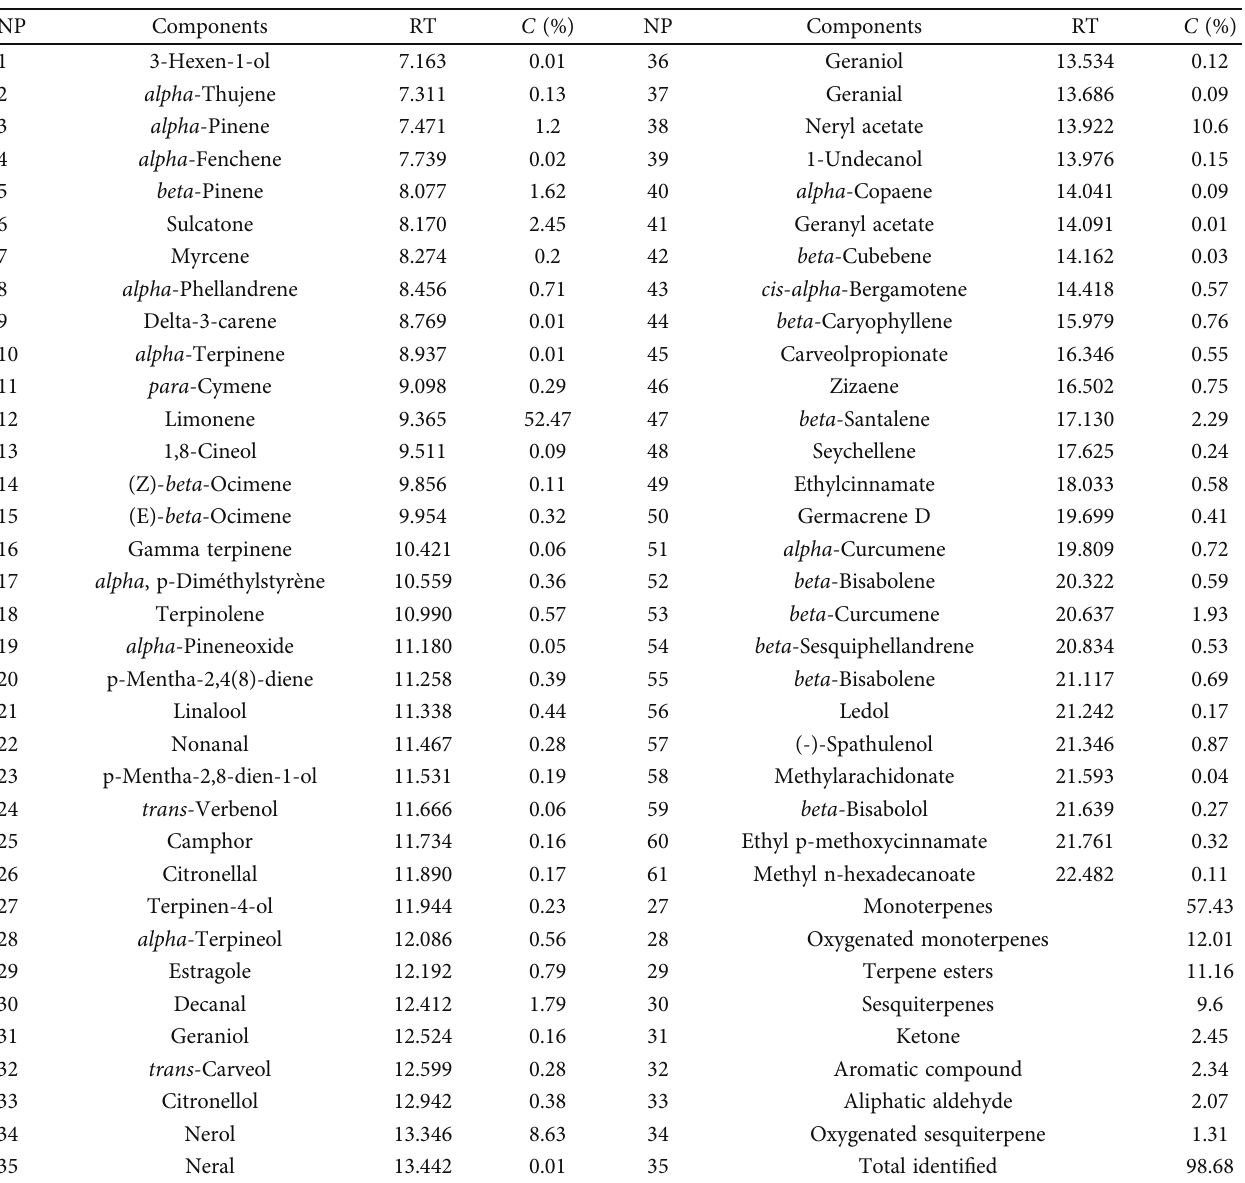
Table 1: Chemical composition of the peel Citrus limon essential